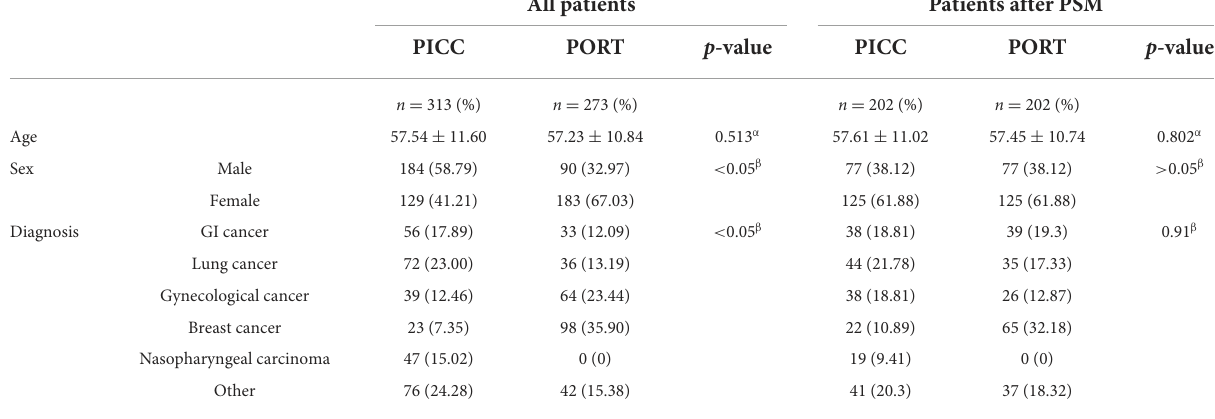
TABLE 3 Demographic